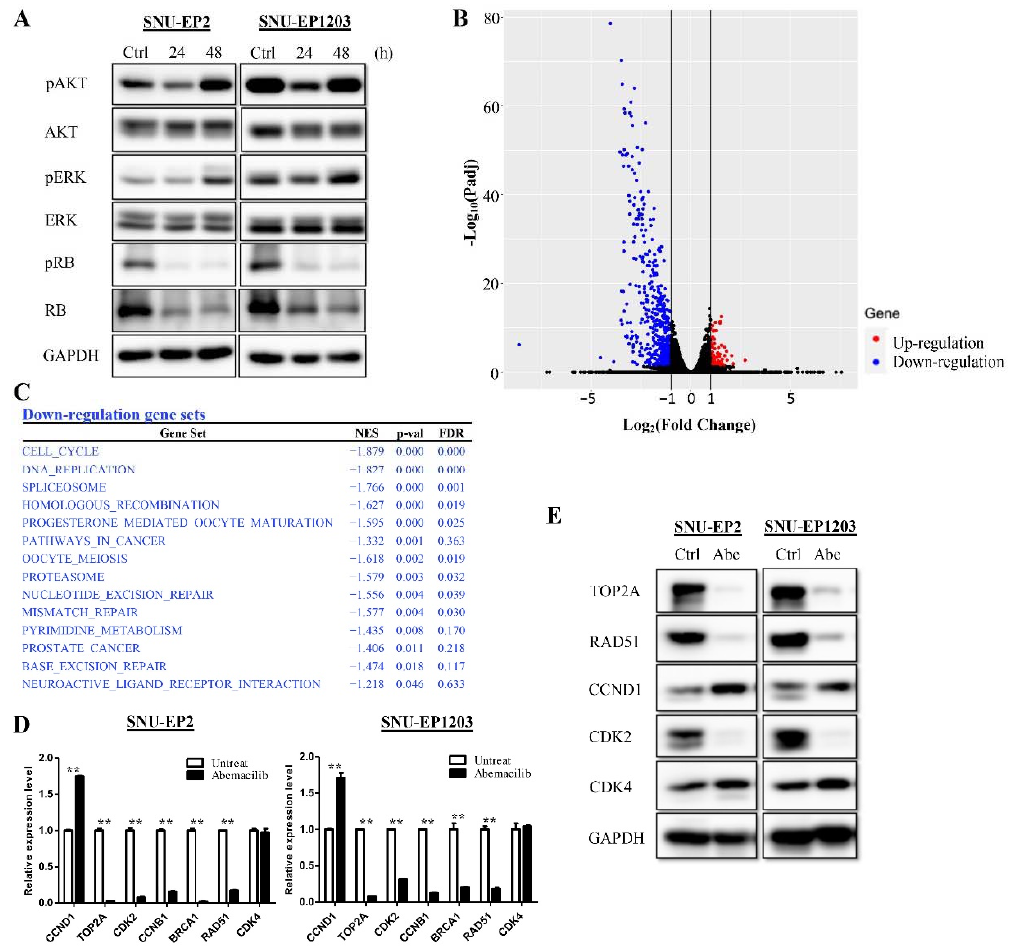
Figure 4. Abemaciclib treatment regulates expression of cell cycle and DNA repair genes. ( A ) SNU-EP2 and SNU-EP1203 cells were treated with abemaciclib (0.25 µ M) for the indicated times and the levels of phosphorylated RB, AKT, and ERK were detected via Western blot analysis. ( B ) SNU-EP2 cells were treated with abemaciclib for 48 h and mRNA-seq was performed. A volcano plot showed significantly upregulated (red) and downregulated (blue) genes. ( C ) Significantly downregulated pathways analyzed by GSEA are listed. ( D , E ) Expression of cell cycle and DNA repair genes in SNU-EP2 and SNU-EP1203 cells was validated by qPCR ( D ) and Western blot analysis ( E ). qPCR results are presented as the mean ± SD for duplicate samples. ** p < 0.01.